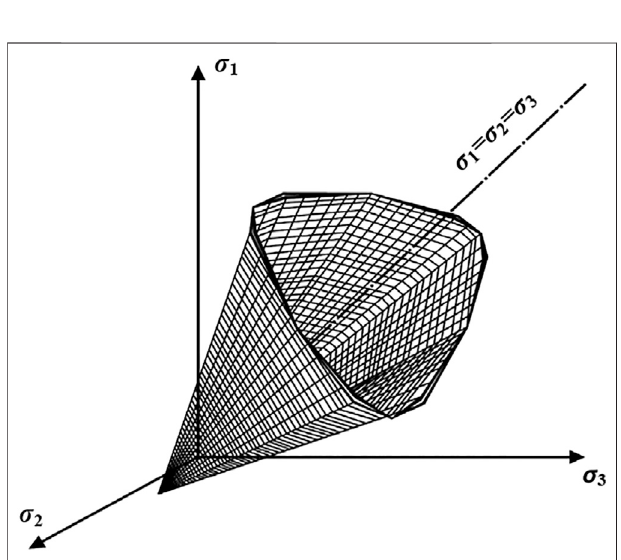
FIGURE 7 | Partial plane limit trace diagram of UST at different temperatures.